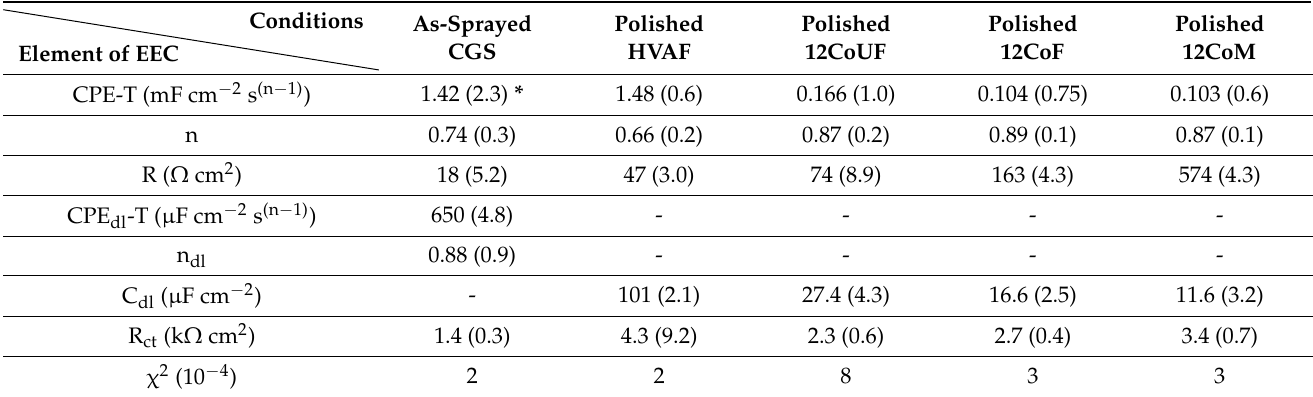
Table 4. Parameters of the EEC used to fit to the EIS experimental of different samples. Rs was normalized to the lower value measured for the samples (Rs = 16 Ω cm 2 ) to better represent all curves at the same graphic, and therefore, the Rs value was not added to the table.